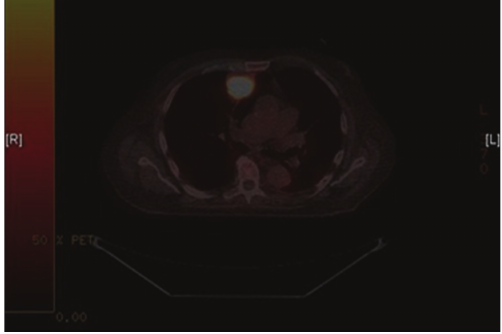
Figure 1: PET image showing avid lesion in the right lung.